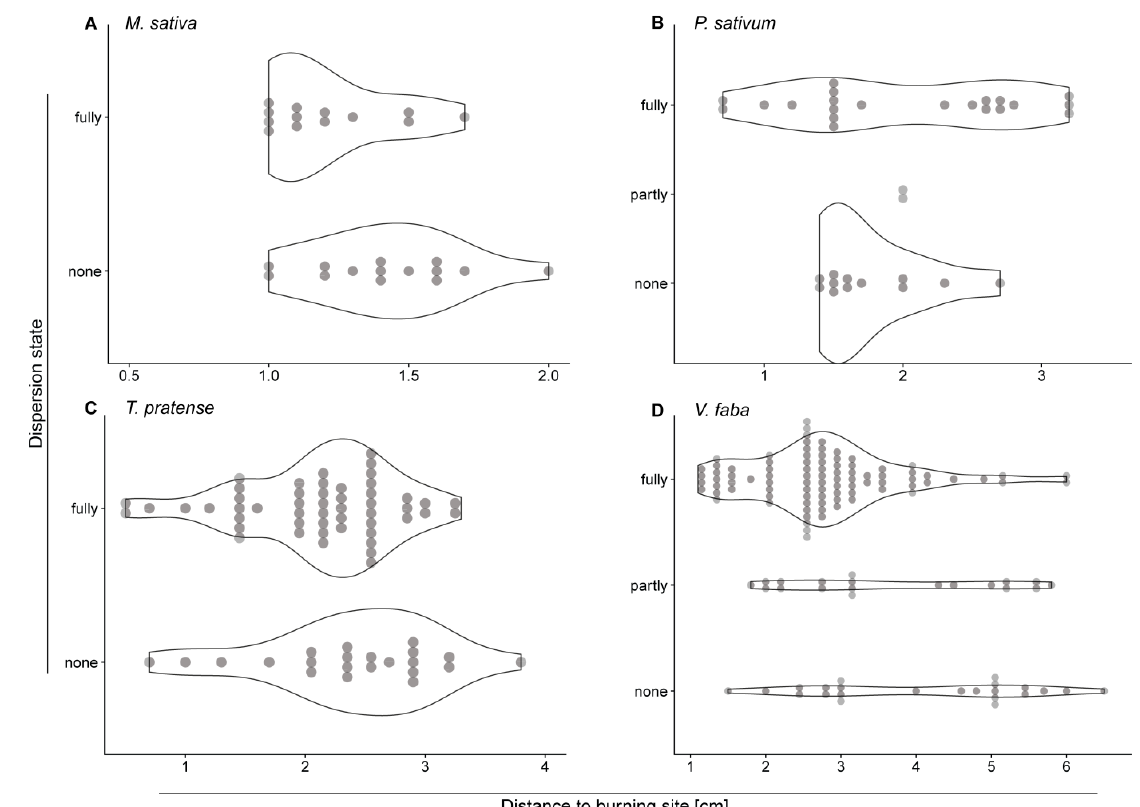
Figure 2. Effect of the distance from the stimulus on the forisome dispersion state (fully, partly, none) in experiments on the target leaflet. Depicted are violin plots with their width adjusted to the number of forisomes observed in a given state of dispersion at a given distance (each forisome indicated by a filled circle). The number of replicates varied between the species: M. sativa ( A ) n = 28, P. sativum ( B ) n = 35, T. pratense ( C ) n = 73, V. faba ( D ) n = 133. Statistical values are shown in Table S2.